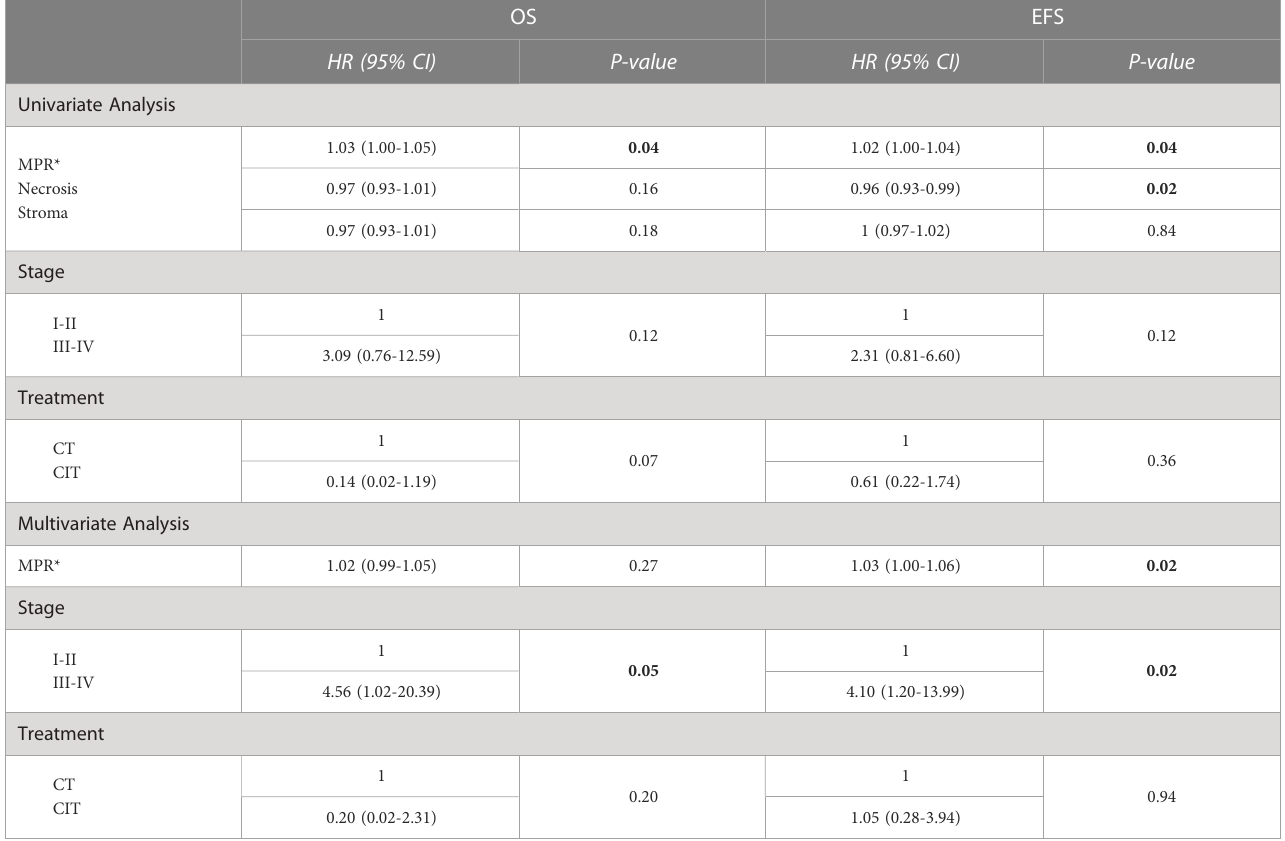
TABLE 3 Univariate and multivariate time-to-event